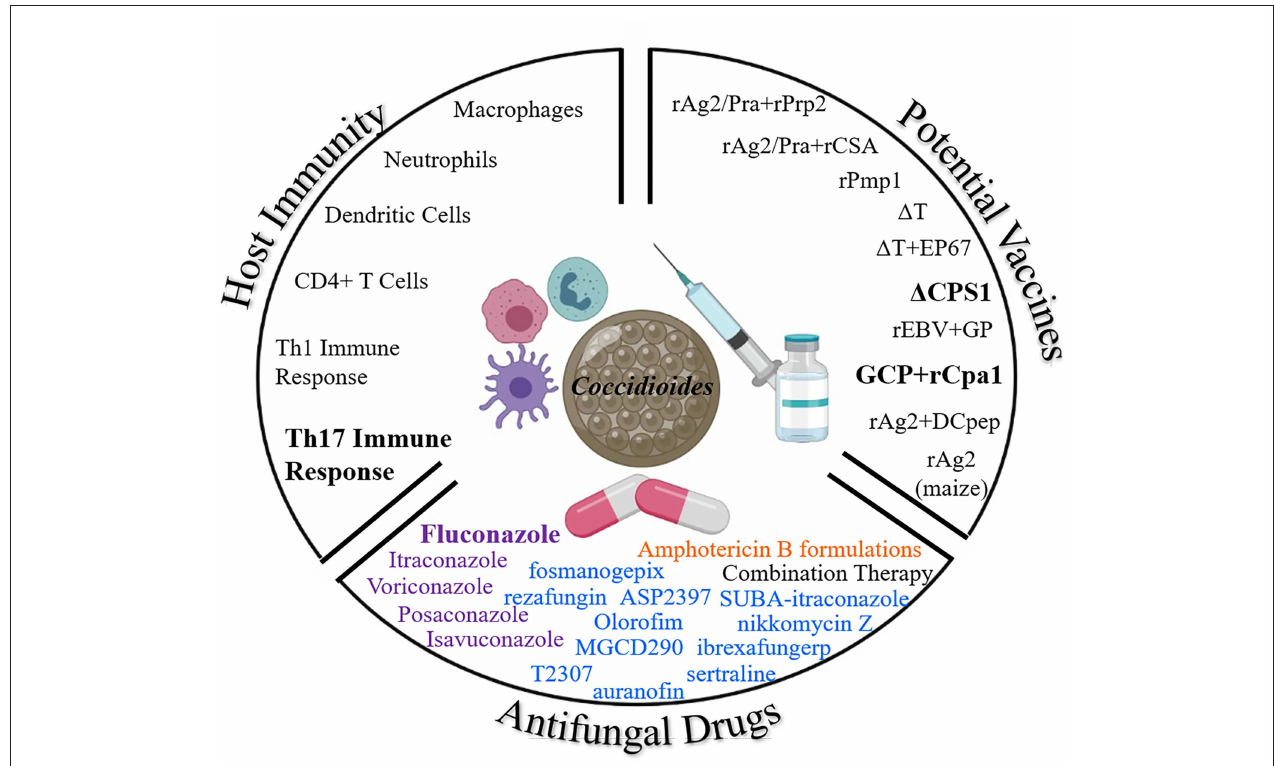
FIGURE 2 | Three Arsenals to Combat Coccidioides . Here we highlight the current battle against Coccidioides from antifungals, potential vaccines, and the protective host immune response. Bolded terms: important for host protection, most common antifungal drug, and most promising current vaccine candidates against coccidioidomycosis. Color coding for antifungal drug classes: purple, Azoles; blue, drugs in development; and orange, Polyenes (Illustration created with BioRender).